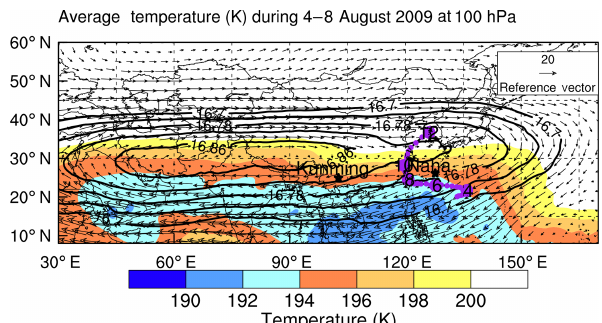
Figure 3. (a) The 5d average (4–8 August) of geopotential height (black lines, > 16 . 70gpkm), temperature (shaded, K), and wind speed (vectors, ms − 1 ) from ERA-Interim at the 100hPa pressure with the tracks of Typhoon Morakot (purple dots). The numbers in purple dots indicate days in August 2009. The black stars mark the locations of Naha and Kunming. Figure 4. Profiles of ozone (blue), mean ozone (grey), relative hu- midity from CFH (RH i FP, black), and temperature (red) in (a) Naha on 4 August and (b) Kunming on 8 August (solid line: observation; dashed line: ERA-Interim; dash-dotted line: